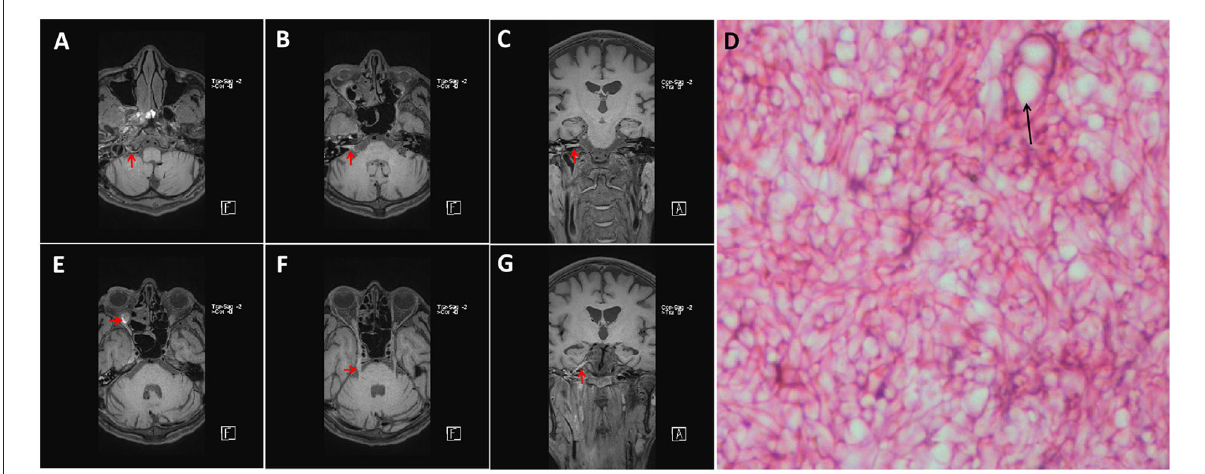
FIGURE1 Enhanced MRI with 3D-T1-SPC sequence results of the patient (a standard dose of gadolinium). The MRI showed enhanced images of the right hypoglossal nerve (A) , the posterior orbital wall (E) , the facial nerve (B,C) , and the trigeminal nerve (F,G) slightly (Red Arrow). Microscopic photograph showing hyphae and Sporangium (Black Arrow) in HE staining [ (D) ,